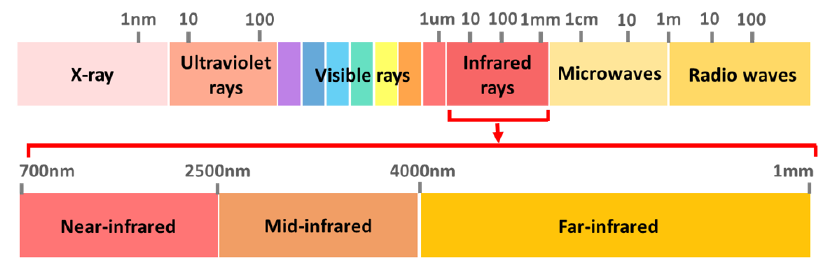
Figure 4. The electromagnetic spectrum.